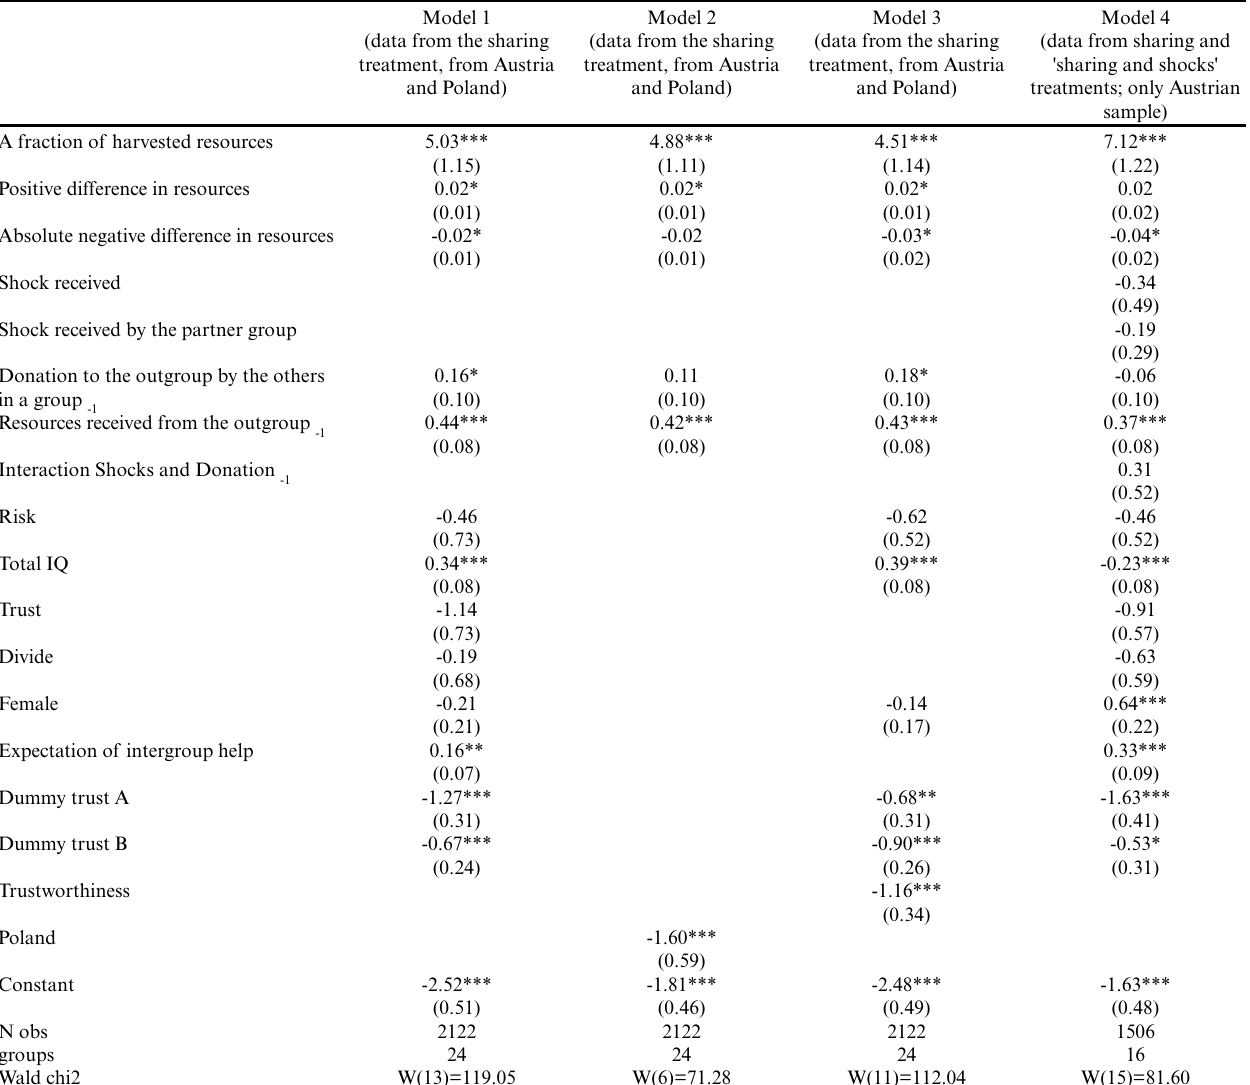
Table 4 . Results from the mixed-level logit panel regressions with the depend variable taking 1 if a subject shared some of his/her harvest with outgroup members and 0 otherwise. The sample includes only data if case resources in the group and in the partner group are larger than 1. Data at the individual level are nested within groups, and then within partner groups, and finally within sessions in the analysis. Standard deviations in